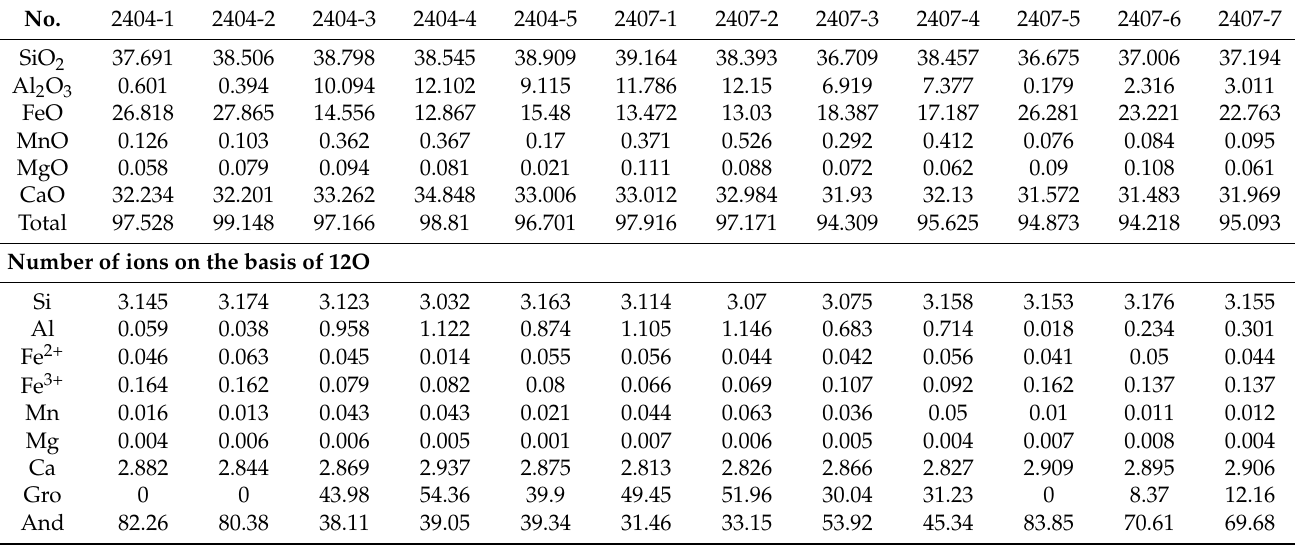
Table 1. Selected major element contents (wt%) by EPMA, in